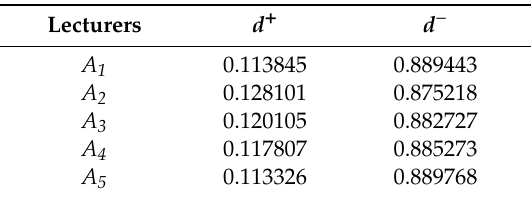
Table 4. The distance of each lecture.